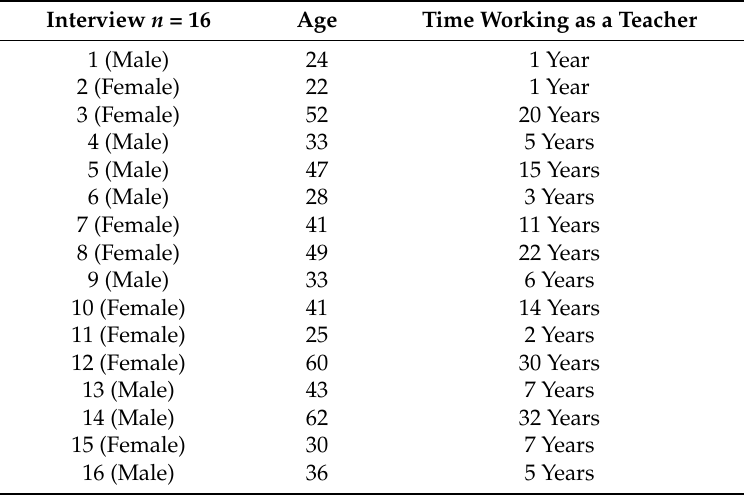
Table 3. Sociodemographic characteristics of teacher (qualitative